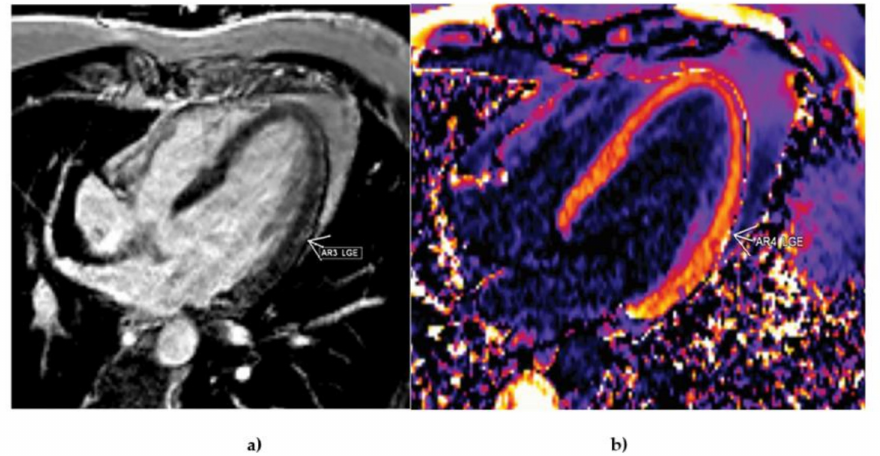
Figure 5. Control cardiac magnetic resonance three months after COVID-19 infection. ( a ) Persistence of late gadolinium enhancement in the basal and mid-lateral left ventricular wall. ( b ) Control CMR mapping detected increased values of postcontrast T2 subepicardial in the basal and medial part of the LV lateral wall in terms of myocarditis sequelae. The focal involvement of the pericardium along the lateral wall of the left ventricle can also be